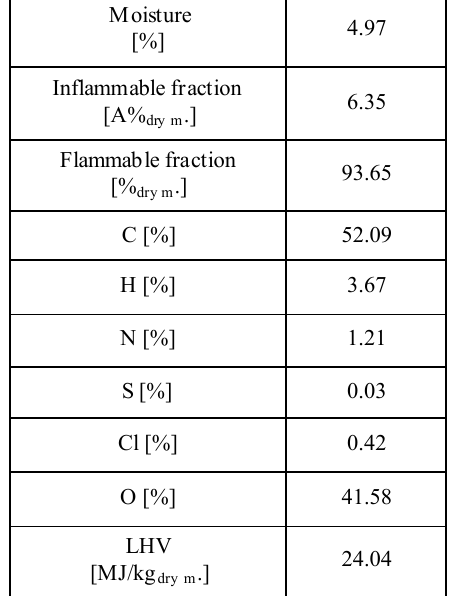
Table 1. Elemental composition of dry mass of surveyed fuels and its LHV calorific value